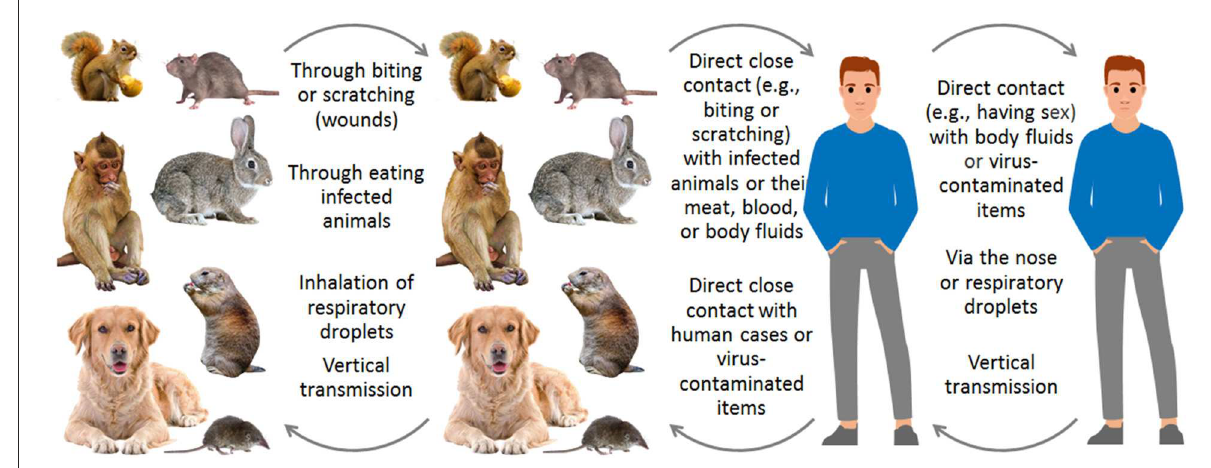
FIGURE3 Transmission routes of MPX in animals and humans.